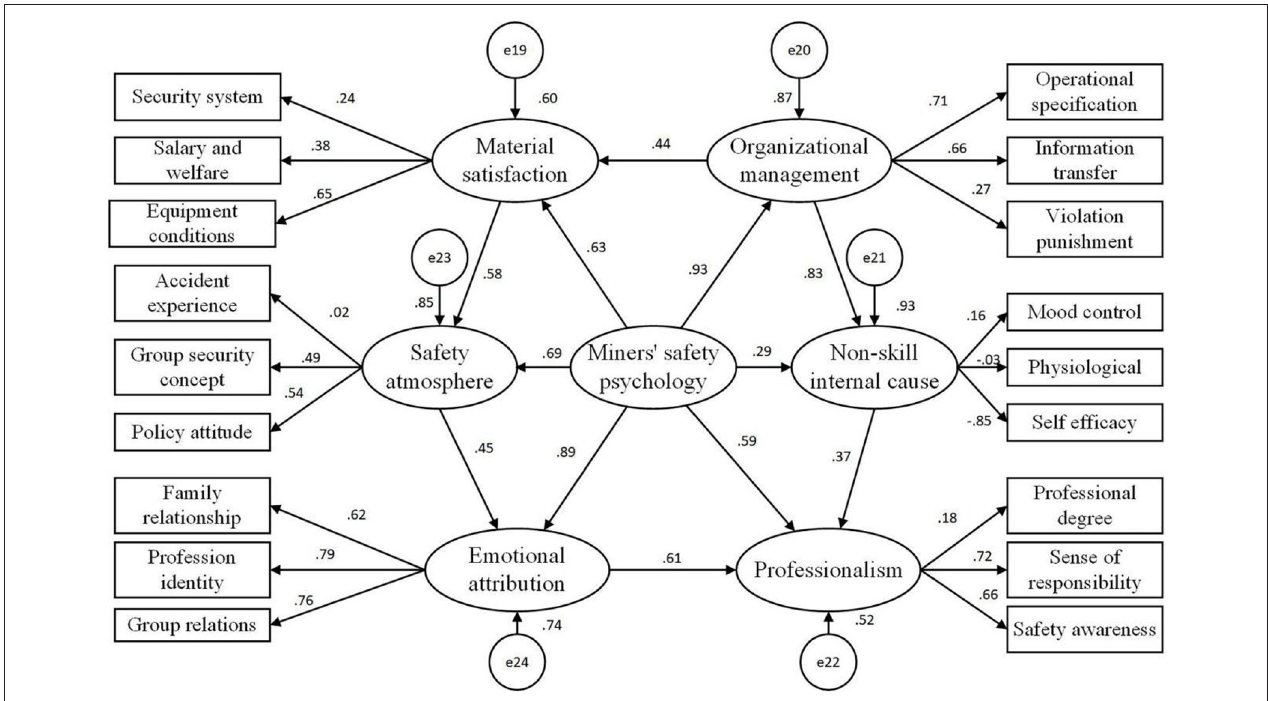
FIGURE 6 | Path map of standardized coefficients of